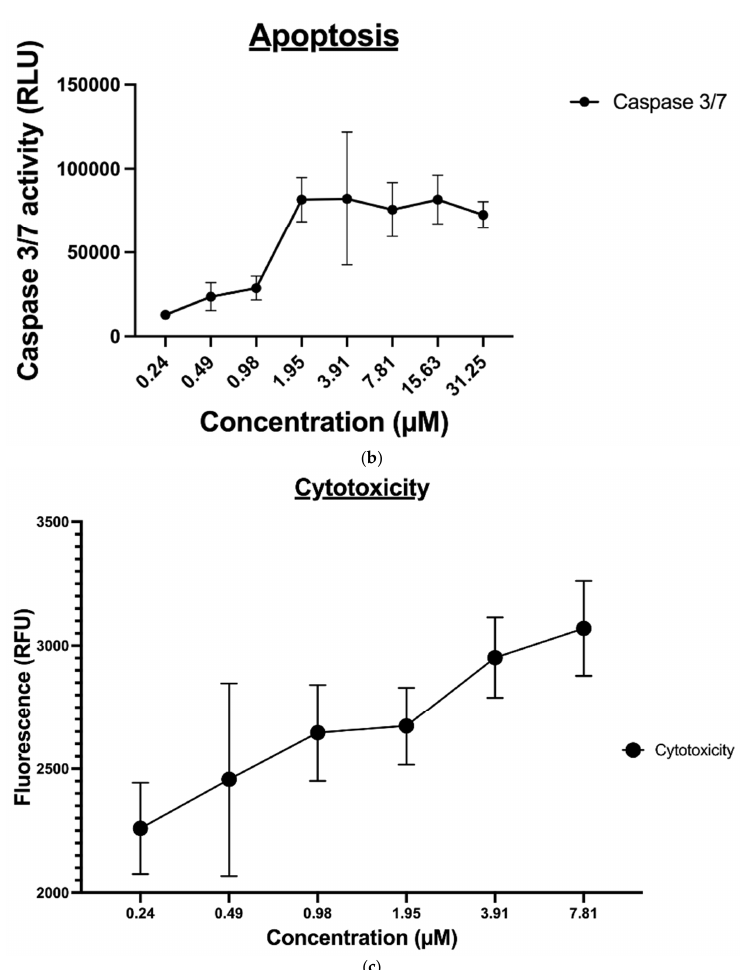
Figure 7. ( a ) The effect of compound 9 on MDA-MB-231 cell viability, ( b ) The effect of compound 9 on MDA-MB-231 cell apoptosis, and ( c ) The effect of compound 9 on MDA-MB-231